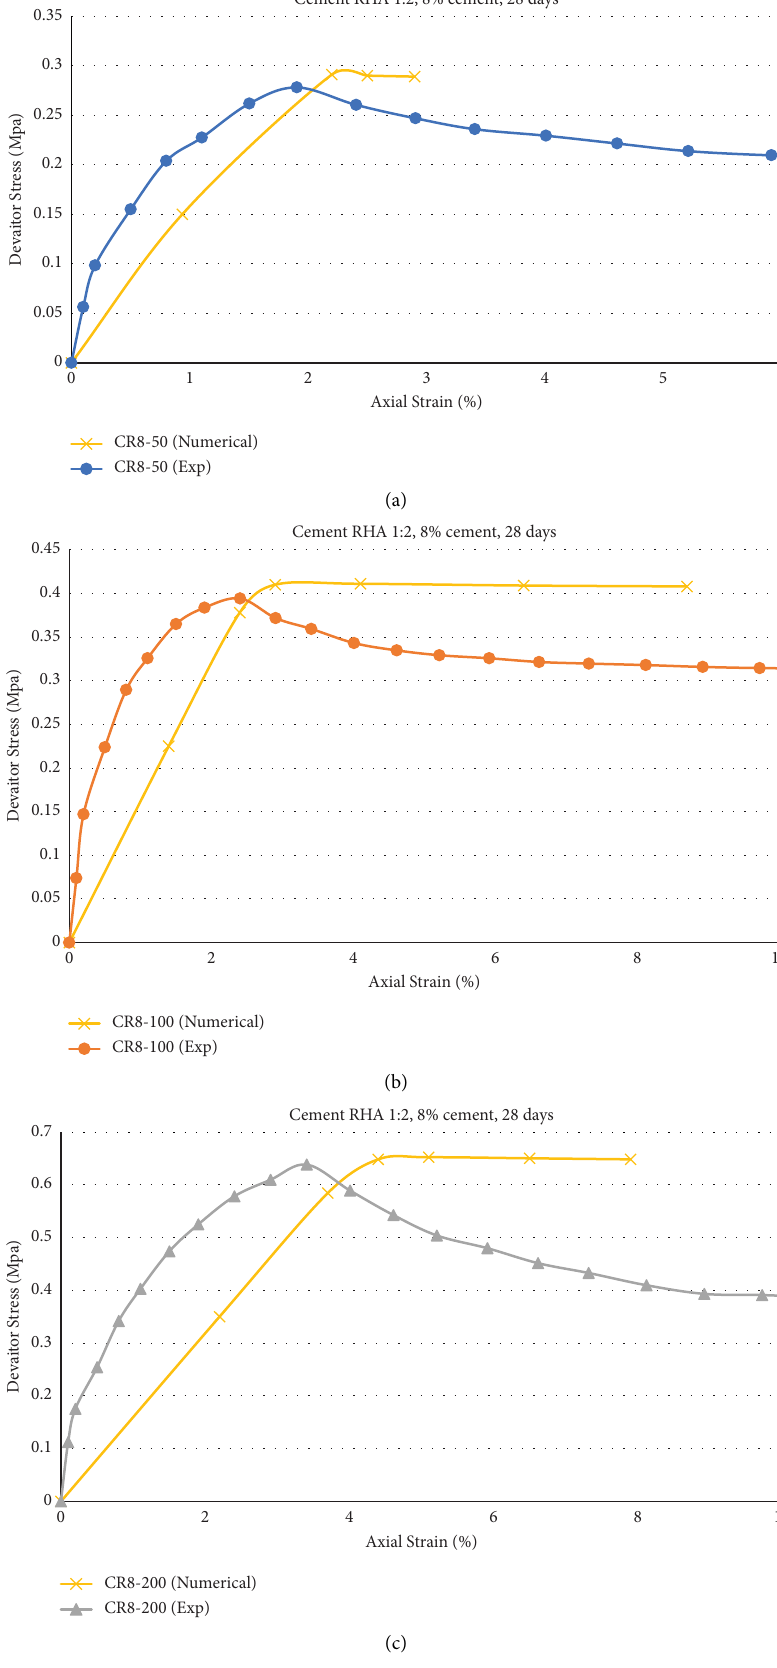
Figure 12: Deviator stress-strain curves for 8% CRHA treated soil (1 :2) after 28 days of curing, under three diferent confning pressures of (a) 50, (b)100, and (c)